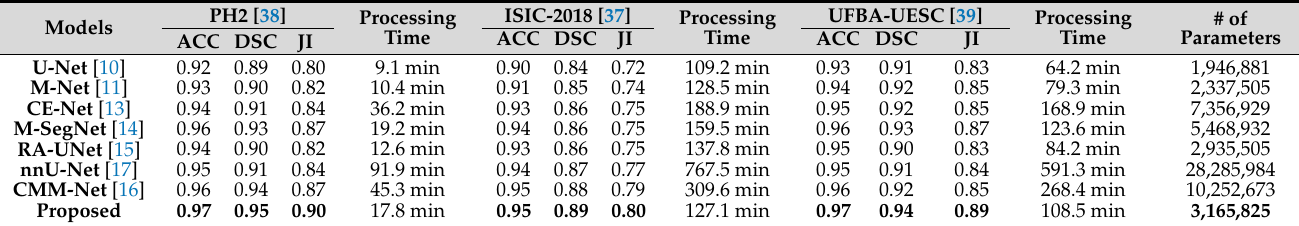
Table 1. Comparison of the segmentation accuracy among the proposed method and conventional